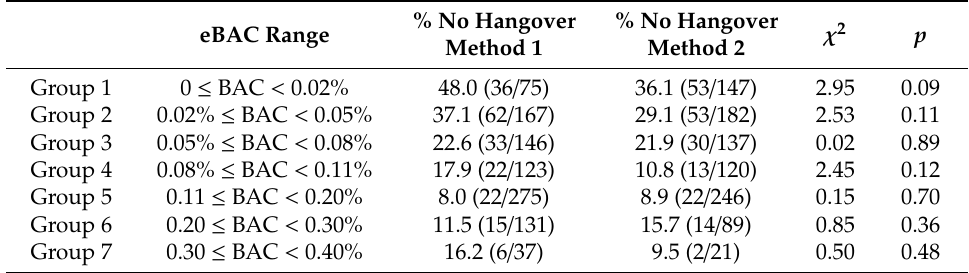
Table 2. Percentage of participants who report no hangover symptoms following alcohol consumption across various eBAC ranges for Method 1 and Method